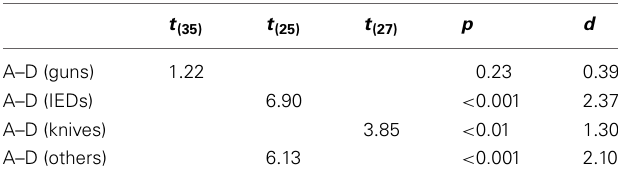
Table 2 | Results of the two-tailed independent samples t -tests comparing detection performance A (cid:2) between conditions A and D for each threat category (guns, knives, IEDs, others) 5